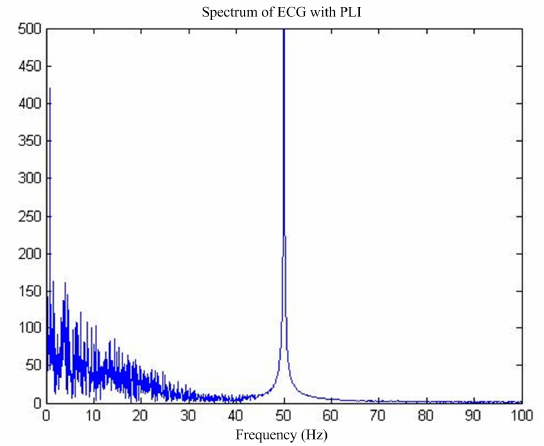
Figure 10. Influence of PLI on the ECG.